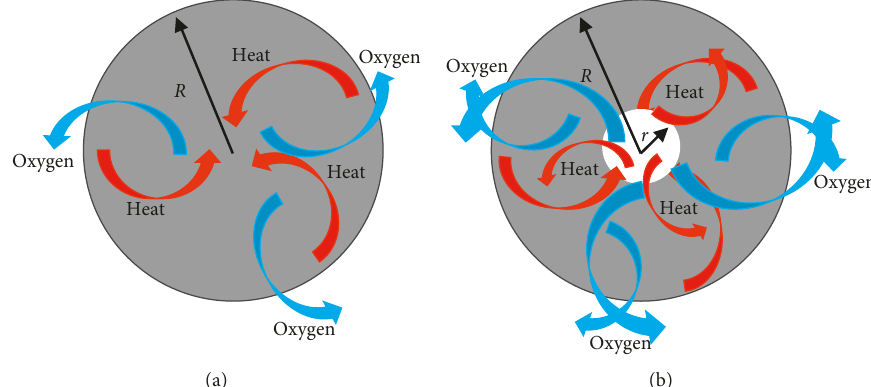
Figure 2: Schematic of heat transfer and oxygen release of solid-structured oxygen candles (a) and hollow-structured oxygen candles (b).